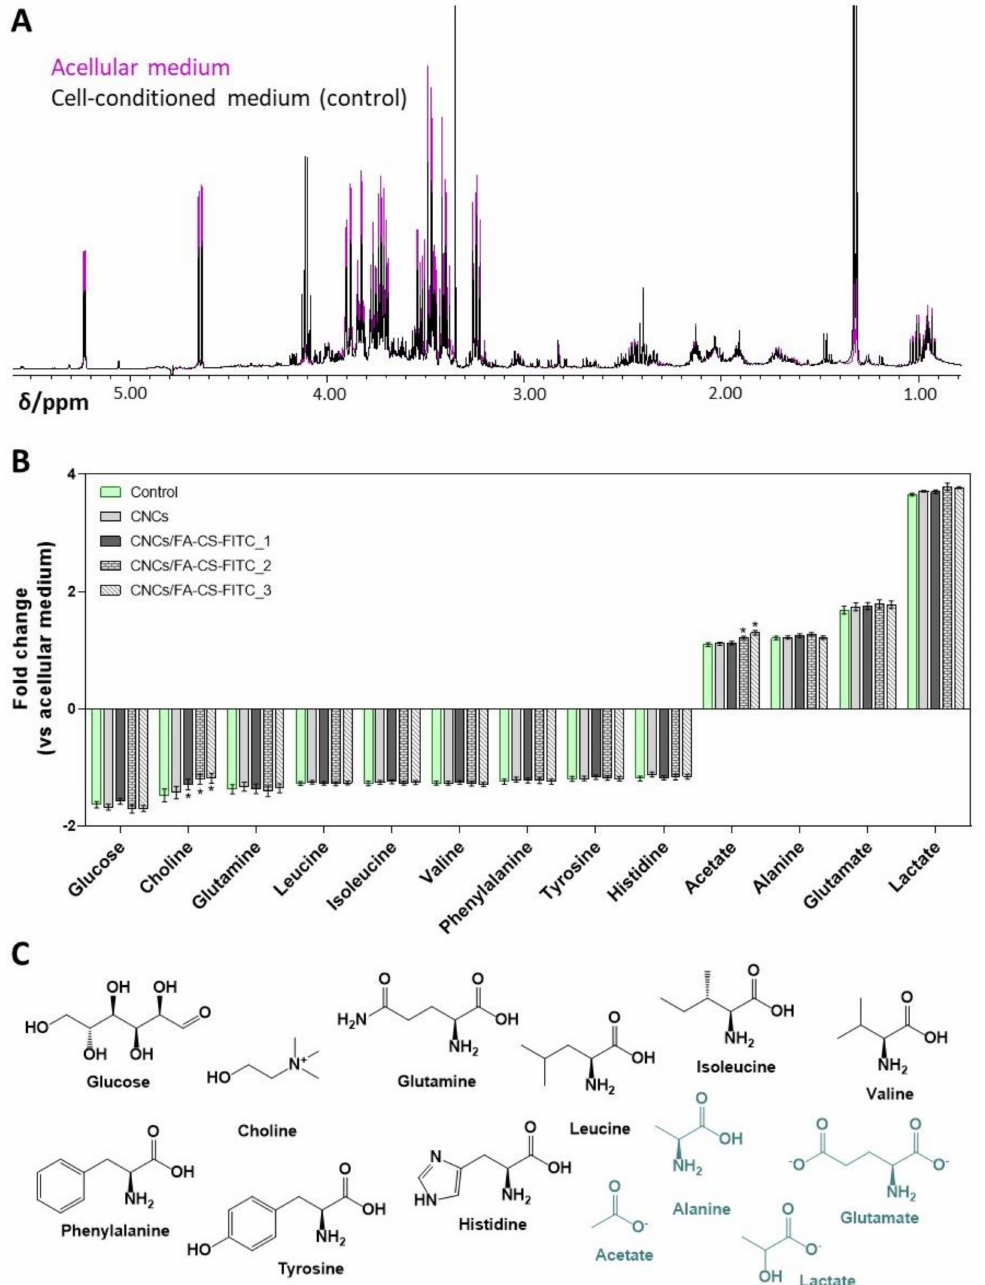
Figure 5. ( A ) 1 H NMR spectra of the acellular medium (pink) and supernatant from MDA-MB-231 breast cancer cells grown for 24 h (black), ( B ) variations in metabolites consumed (negative bars) and excreted (positive bars) by the MDA-MB-231 cells, under control conditions and upon treatment with 200 µ g mL − 1 of CNCs, CNCs/FA-CS-FITC_1, CNCs/FA-CS-FITC_2 and CNCs/FA-CS-FITC_3 for 24 h (the symbol * represents the means with a significant difference from the control at p < 0.05), and ( C ) chemical structures of the consumed (black) and excreted (green)